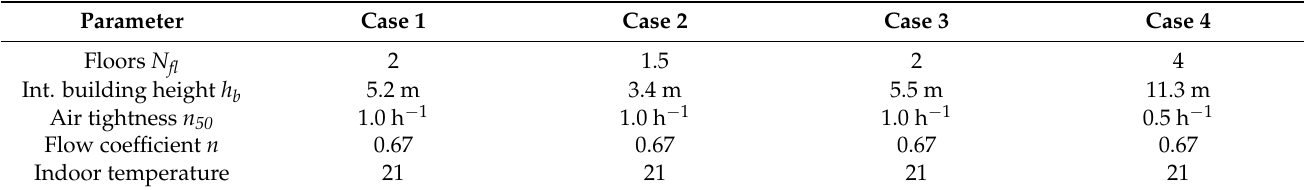
Table A2. Building information and assumptions used in the building infiltration